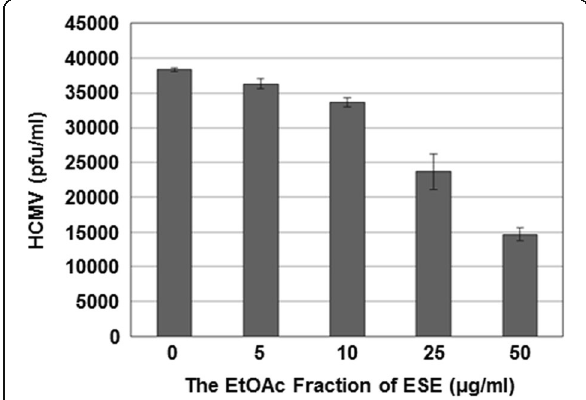
Fig. 4 Dose-dependent suppression of HCMV replication by the EtOAc fraction of ESE. HFF cells were infected with serially diluted HCMV-Towne and treated with either DMSO or the EtOAc fraction of ESE at concentrations of 5, 10, 25 or 50 μ g/ml. Cells were re-treated with DMSO or the EtOAc fraction of ESE every 3 days after infection. At 14 days following infection, the number of plaques was counted to determine pfu/ml using a plaque assay